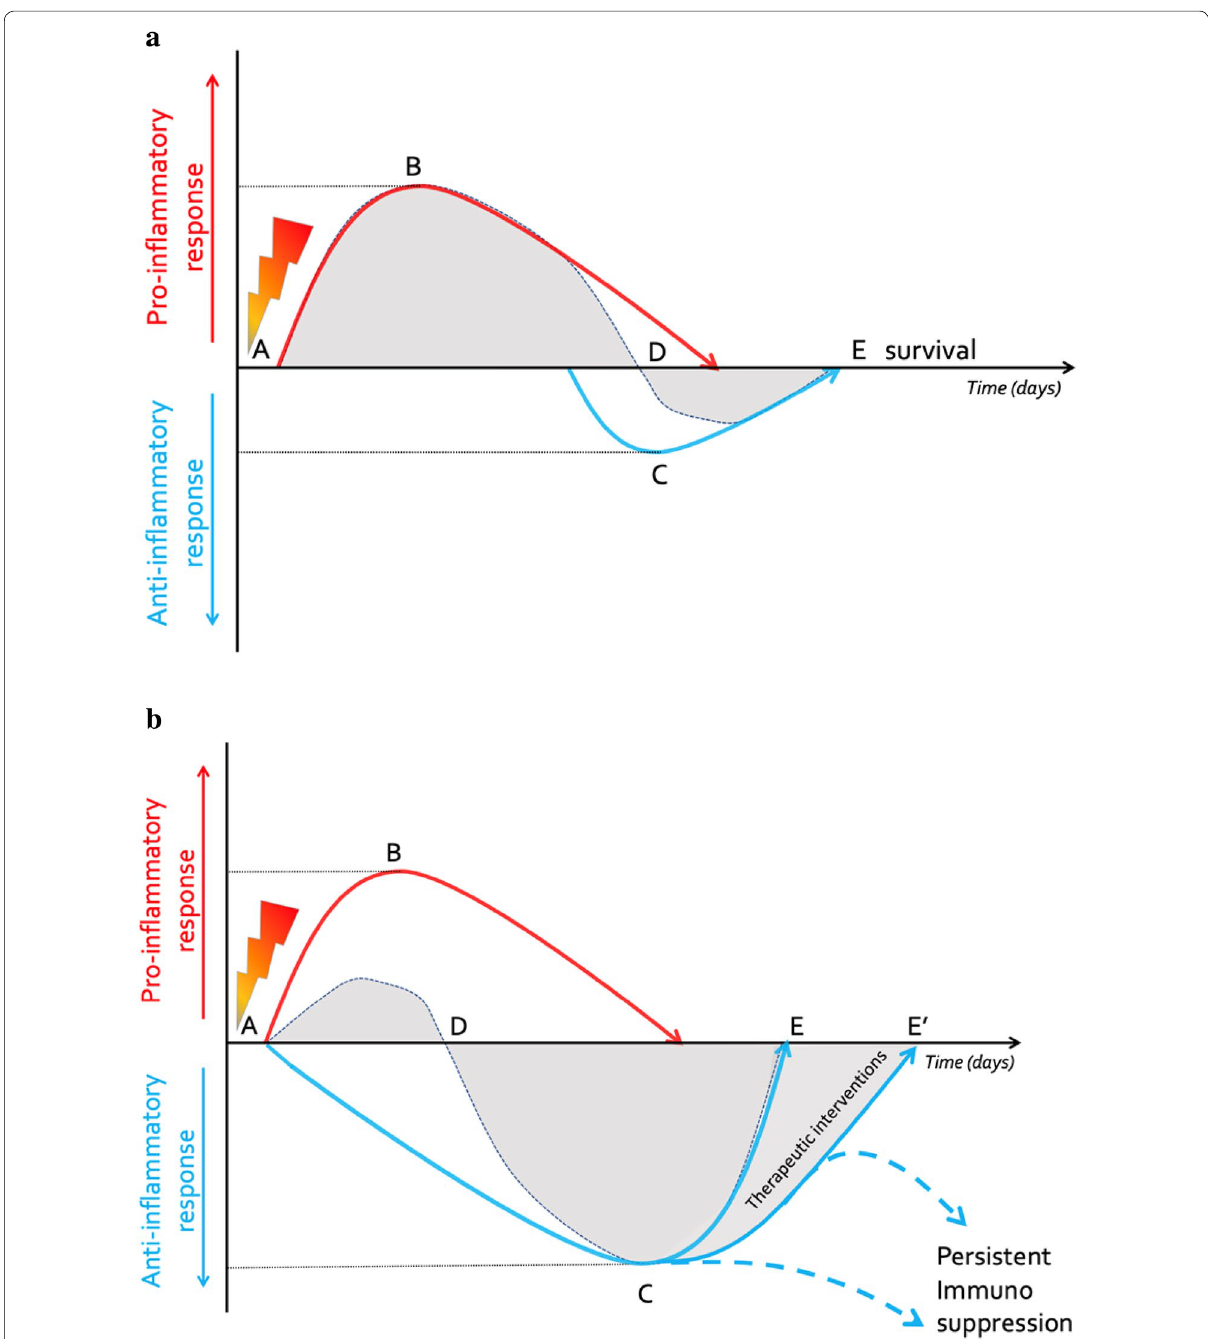
Fig. 2 Balance between the pro‑ and anti‑inflammatory mediators. a Following an initial (infectious) insult (A), normally after correct (antibiotic) treatment the antagonistic forces of pro‑inflammation (B), and anti‑inflammation (C) regain balance (grey area shows net effects) maintaining healthy homeostasis (D), that will lead to recovery and survival (E). Adapted from Pfortmueller et al. with permission (Open Access CC BY Licence 4.0) Intensive Care Medicine Experimental (2017) 5:49 https ://doi.org/10.1186/s4063 5‑017‑0163‑0. b Following an (infectious) insult (A), during a dysregulated host response the pro‑inflammatory (B) forces initially overwhelm anti‑inflammation (C) resulting in an imbalance (D), followed by immunosuppression and increased anti‑inflammatory mediators (grey area shows net effects). With different therapeutic interventions recovery (E) can be obtained or delayed (E’) or the patient can evolve into a state of persistent immunosupression or paralysis. Adapted from Pfortmueller et al. with permission (Open Access CC BY Licence 4.0) Intensive Care Medicine Experimental (2017) 5:49 https ://doi.org/10.1186/s4063